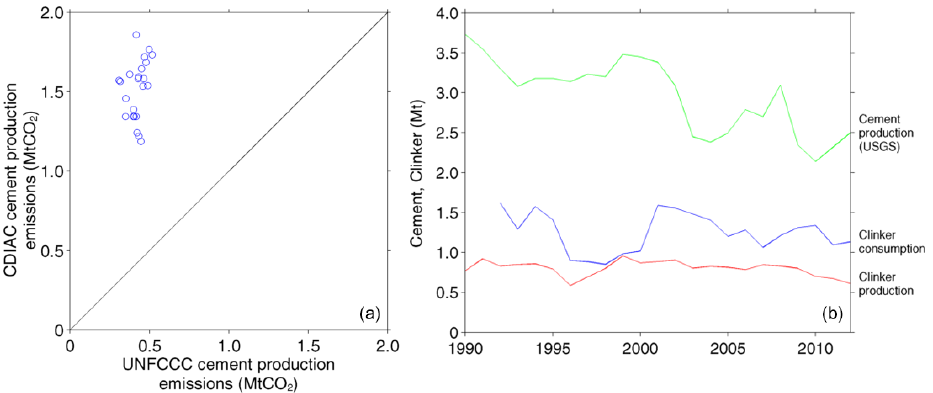
Figure A3. The Netherlands: (a) CDIAC vs. UNFCCC; (b) linker, cement. Note “Clinker consumption” is production plus imports less exports, but excludes stock changes. Sources: UNSD (2015), UNFCCC (2014), van Oss (1994–2018), and Boden et al.